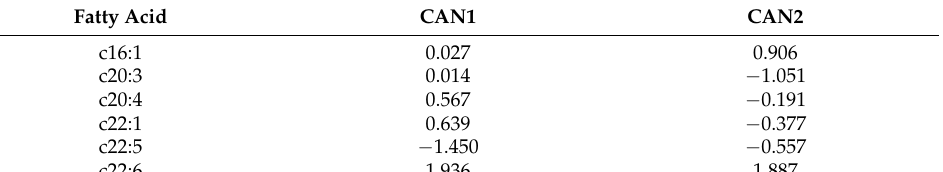
Table 4. Pooled within class standardized canonical coefficients (loadings) on the first two canonical variates estimated from the fatty acid profiles of northern Largemouth bass whole-body samples (Trial 1).